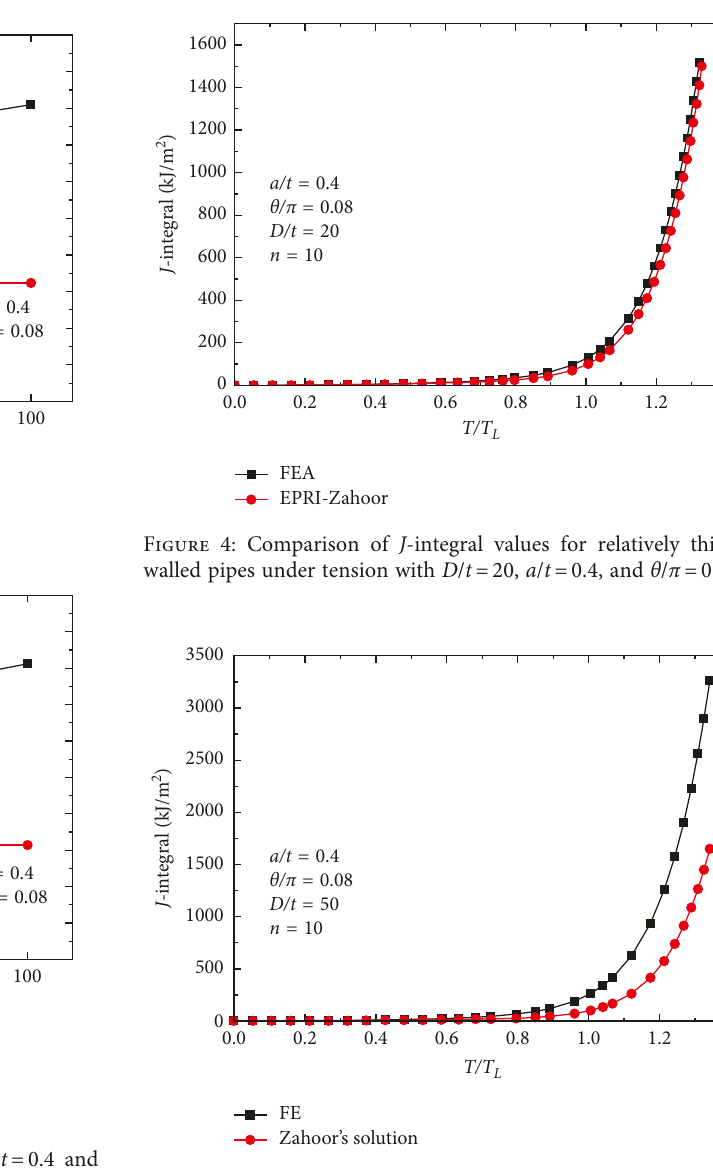
50, a / t 0.4, and θ / π 0.08. (cid:31) (cid:31) (cid:31)